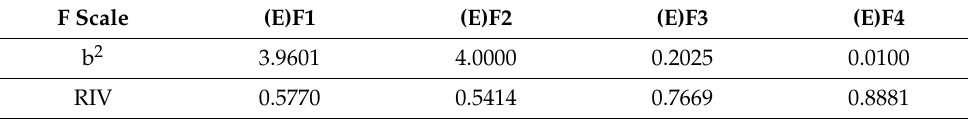
Table 5. Tornado trend square b 2 and tornado RIV (# year -1 ).